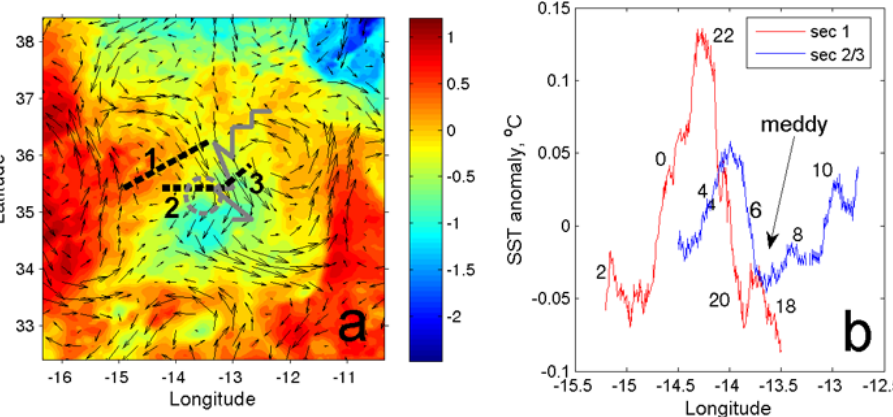
Fig. 7. (a) Anomalies of SST ( ◦ C) on 24 August 2010. The segments of the cruise tracks 1 and 2–3 are shown. The thick grey line marks the meddy track; the position of the surface signal of the meddy on 24 August 2010 is marked with a dashed circle. AVISO altimetry currents are overlaid. (b) Temperature anomalies from the ADCP-incorporated thermometer at 4-m depth along the transects 1 and 2–3, as shown in (a) . Linear trends along the segments of the sections are removed. The numbers represent the time (hours of day) of temperature